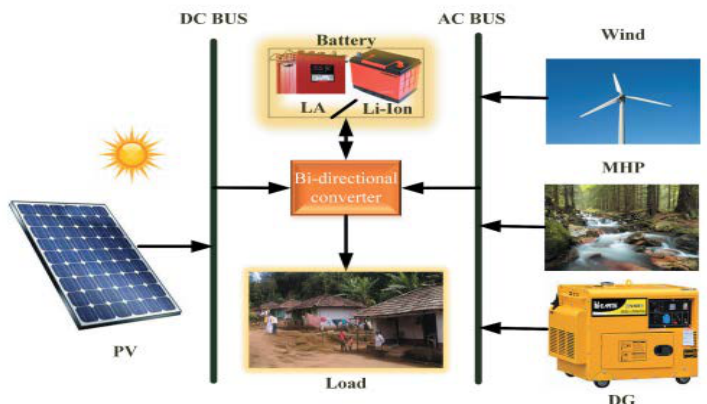
Figure 2. HRES schematic diagram.